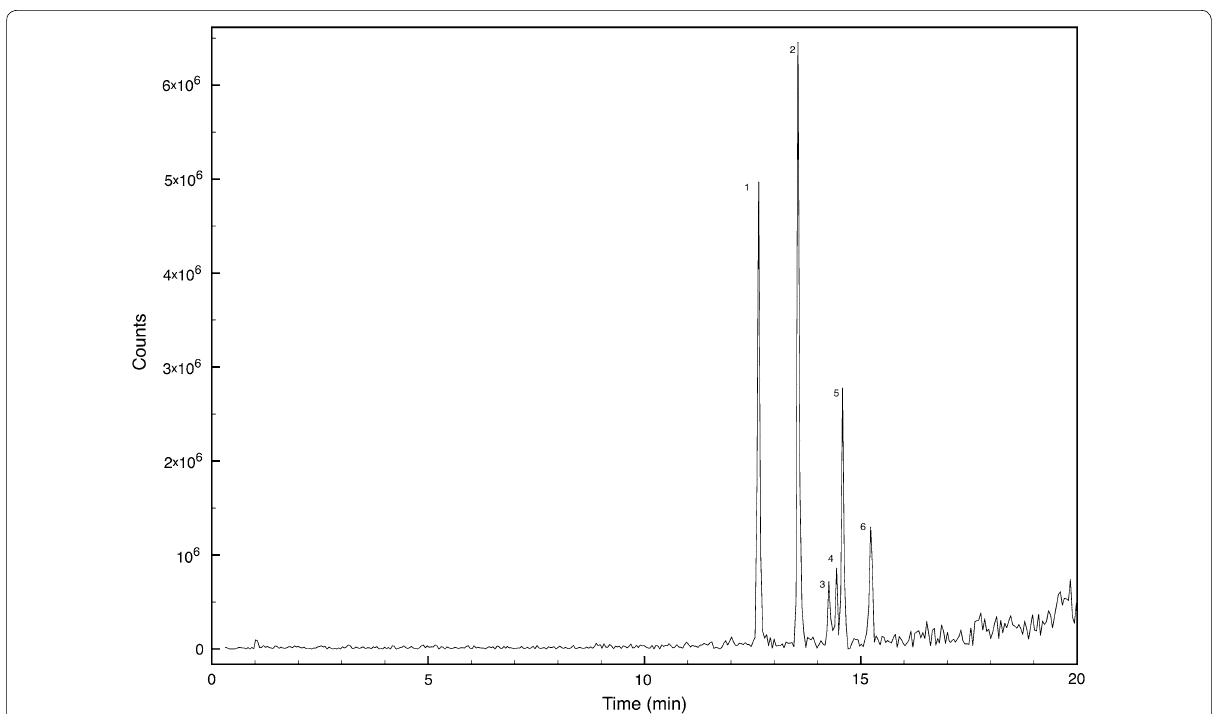
Fig. 9 Total ion chromatogram of glycolipid homologues produced by P. septica OOWS-10. Peaks are numbered according elution order as reported in Table 2